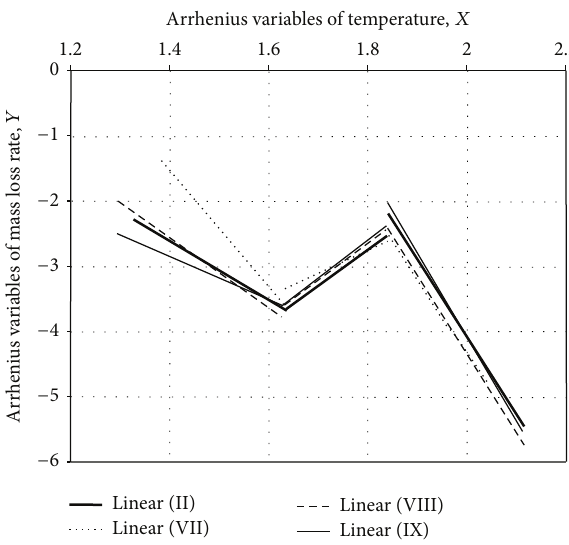
Figure 5: Influence of moisture (4%; 8%; 26%;